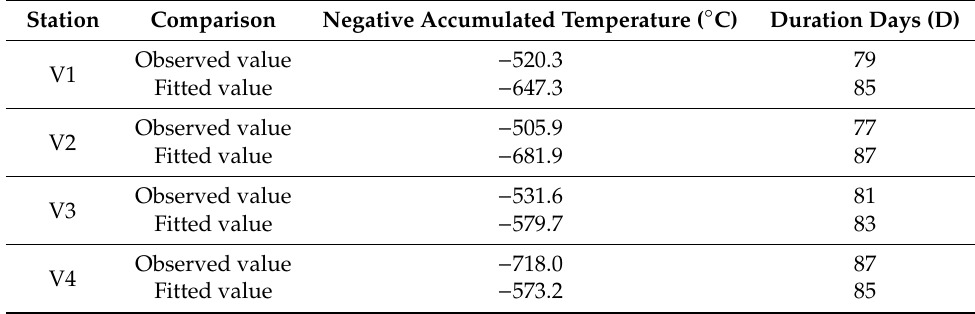
Table 3. Comparison of observed and fitted values of negative accumulated temperature.